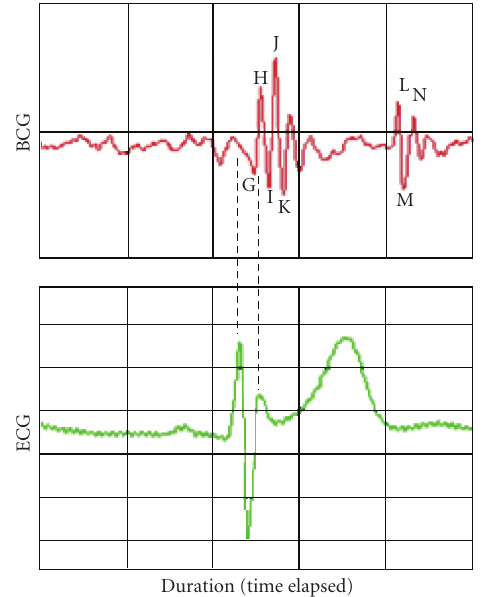
Figure 1: BCG and ECG signals of a single heart-cycle as recorded by the microsensor with the annotation referenced to